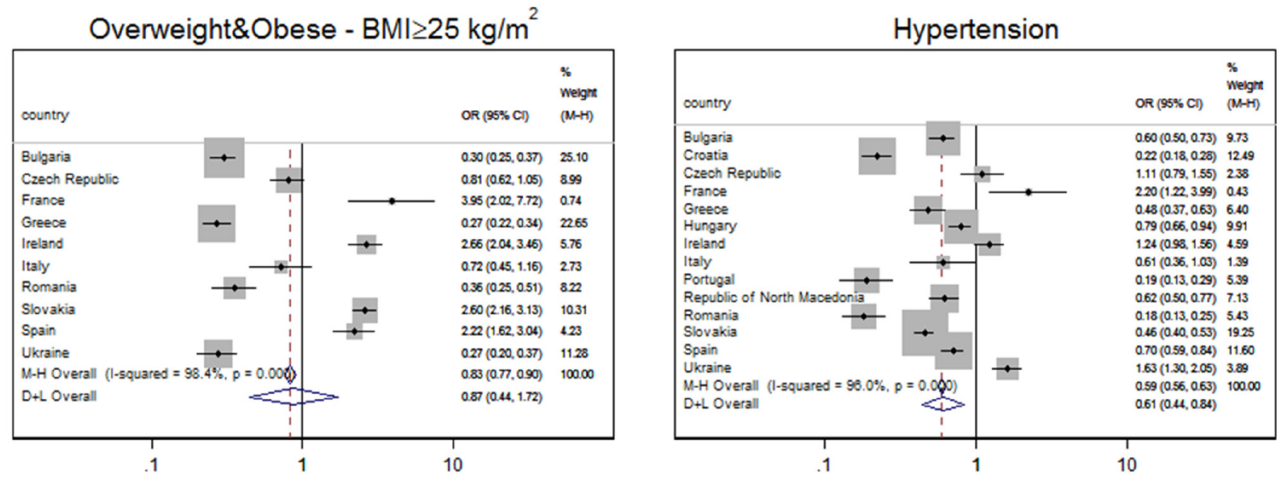
Figure 1. Forest plot of the association between the Roma ethnicity and higher odds ratio (OR) for the prevalence of various CVD risk factors (smoking, diabetes, abdominal obesity, and metabolic syndrome), compared to the majority population. Results are stratified by country.